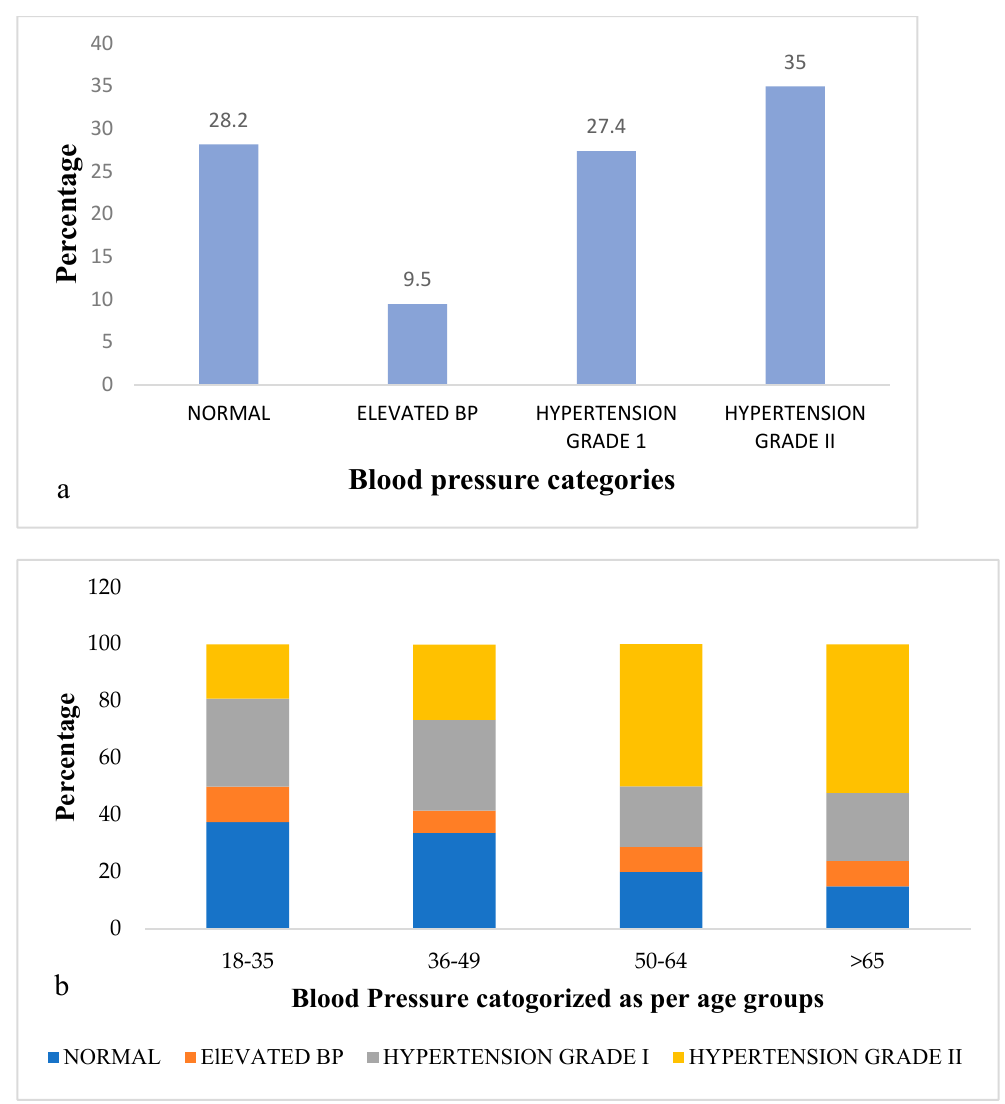
Figure 1. Distribution of participants according to their Blood pressure.